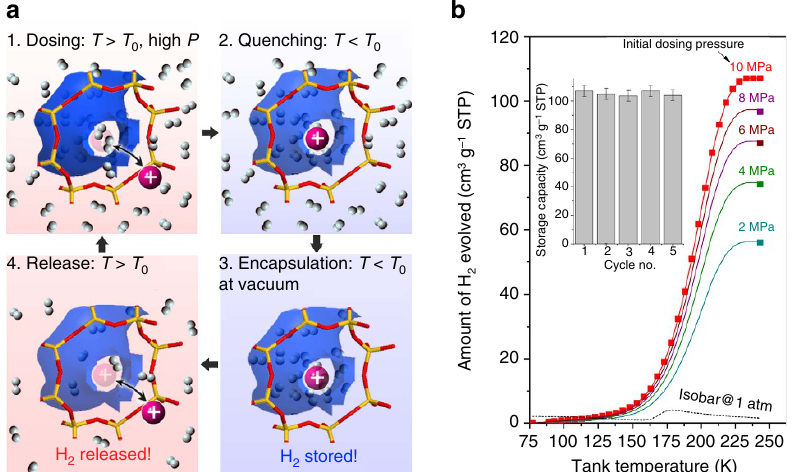
Figure 6 | Physical storage of H 2 by encapsulation without sustained external pressure. ( a ) Four-step procedure for reversible encapsulation and decapsulation of H 2 in materials with temperature-regulated guest admission: (1) At temperatures above the threshold, T 0 , high-pressure dosing is used to store a significant quantity of H 2 within the material’s pore volume. (2) The material is quenched to below T 0 so the door-keeping group closes off access between the pore space and the environment. (3) H 2 remains encapsulated inside the material’s pore space even when the external pressure is replaced with a vacuum as long as the temperature is below T 0 . (4) Controlled decapsulation of the gas into the low pressure environment is achieved by bringing the system temperature above T 0 , with the cumulative amount evolved providing a measure of the initial storage. This storage and release cycle is fully reversible and regulated by heat transfer. ( b ) Measured amount of H 2 decapsulated from r2 KCHA during step (4) as a function of system re-heating temperature after dosing with different initial pressures. Inset: cyclical performance of H 2 encapsulated at a dosing pressure of 10MPa by following the above four-step procedure across five consecutive experiments, showing steady and repeatable H 2 storage capacity (see Supplementary Table 9 for detailed